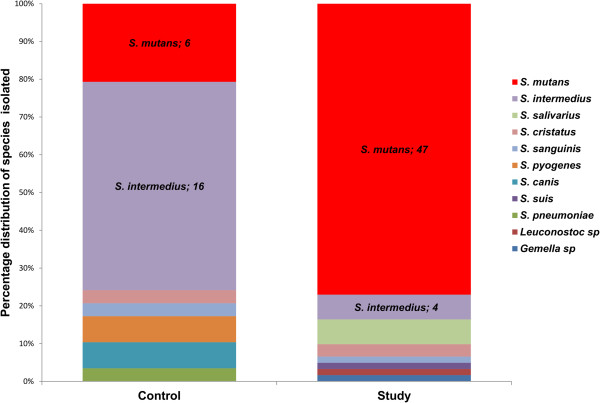
Range and relative share of Streptococcus species in groups - study and control.